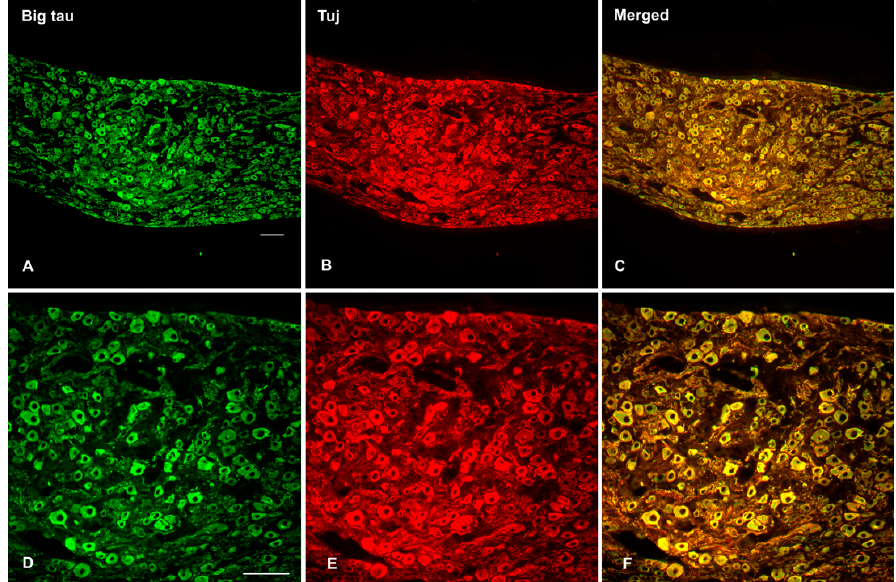
Figure 4. Histological analysis of Big tau expression in adult SCG tissue. Sections from adult SCG were double stained with Big tau and Tuj (neuronal marker) antibodies to analyze the expression and distribution of Big tau expression in SCG. The analysis shows that virtually all SCG neurons expressed Big tau ( A , D ) which co ‐ localized with Tuj staining ( B , E ), shown in merged image ( C , F ). The bottom panel shows high magnificent images derived from the top panel double stained for Big tau and Tuj ( D – F ) confirming that all neurons expressed Big tau. Scale bar = 100 μ m.